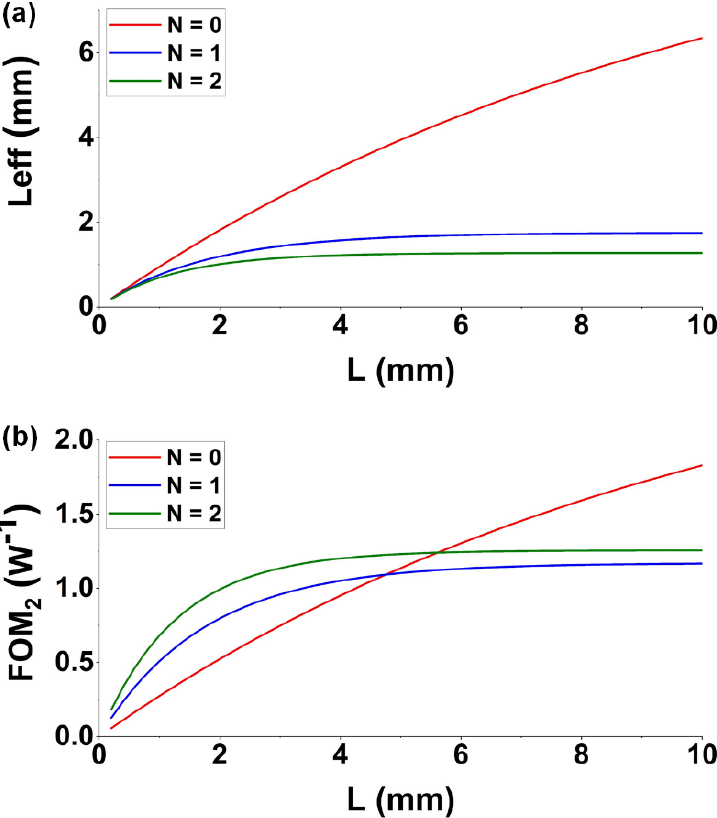
Figure 6. ( a ) Effective interaction length ( L eff ) versus waveguide length ( L ) for GO-coated SOI nanowires uniformly coated with one and two layers of GO. ( b ) FOM 2 versus waveguide length ( L ) for hybrid waveguides uniformly coated with one and two layers of GO. In ( a , b ), the corresponding results for uncoated waveguides ( N = 0) are also shown for comparison.